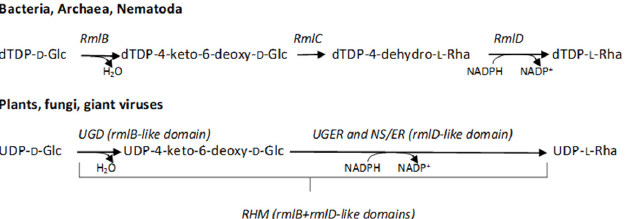
Figure 1. The L-Rha biosynthetic pathways in the different kingdoms. In Bacteria, Archaea, and Nematoda, the pathway starts from dTDP-D-Glc and proceeds through three steps, 4,6-dehydration, 3,5-epimerization, and 4-reduction, catalyzed by RmlB, RmlC, and RmlD, respectively. In Eukaryota and giant viruses, the preferred substrate of 4,6-dehydratase, which presents an rmlB -like domain, is UDP-D-Glc; this reaction is followed by epimerization and reduction carried out by single bifunctional enzymes characterized by an rmlD -like domain (L780/UGER from Mimivirus, NRS/ER from plants and fungi). In plants, the rmlB - and rmlD -like domains are also found in a single polypeptide chain